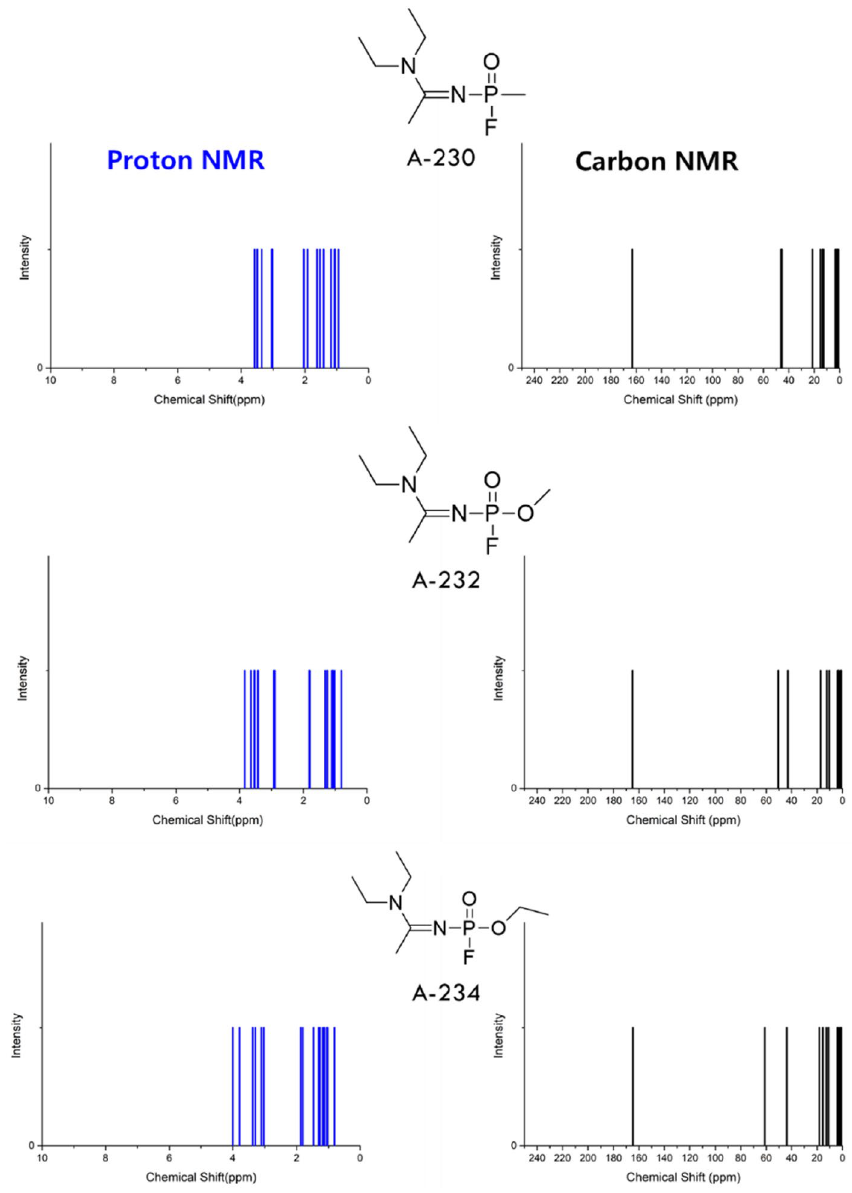
Figure 3. The structure of each Novichok candidate and its predicted 1 H and 13 C NMR spectra. Chloroform was estimated for experimental sampling; therefore, the M06-2X/6-311 + G(2d,p) and MPW1PW91/6-311 + G(2d,p) functionals/basis set combinations were used for the DFT